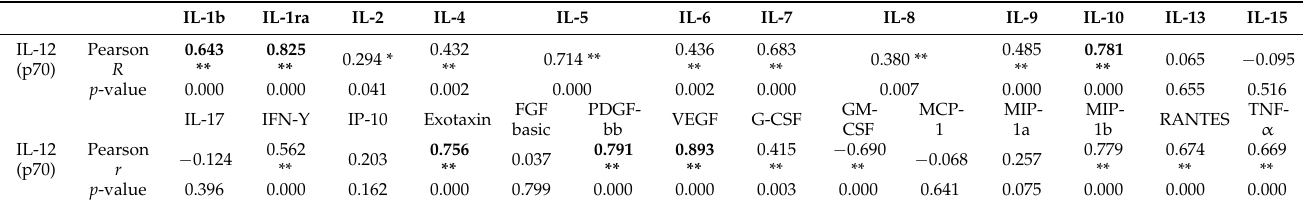
Table 1. Correlation between CSF levels of IL-12 (p70) and various cytokines in patients with encephalopathy.